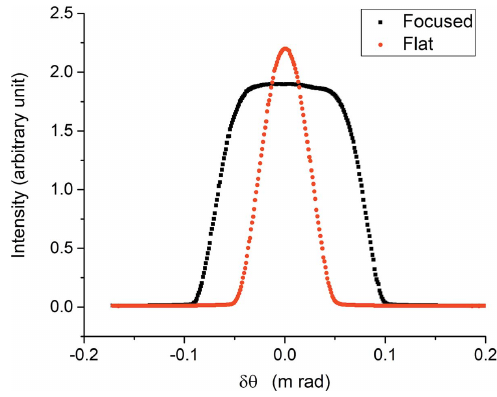
Figure 7 The rocking curve at 12 keV for the flat and focused crystals.